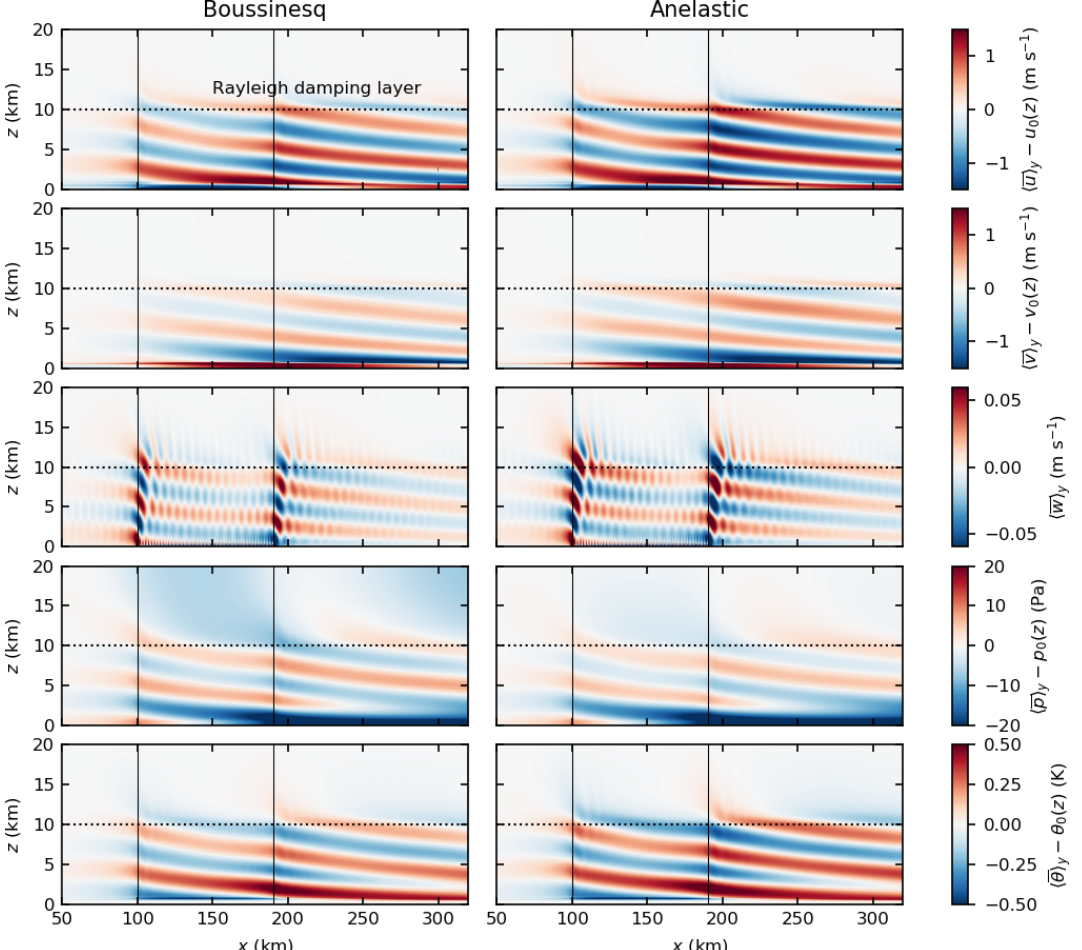
Figure A1. Wave fields for the test simulation with Boussinesq approximation (left) and anelastic approximation (right). All quantities are averaged in time and along y and are given as deviations to the inflow